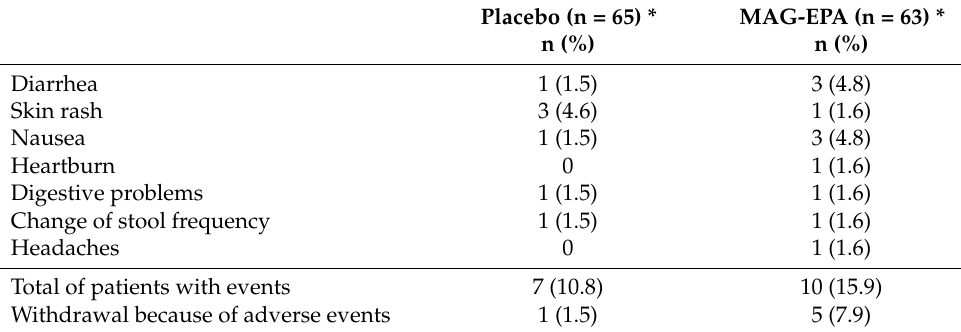
Table 4. Reported adverse events for the entire study.